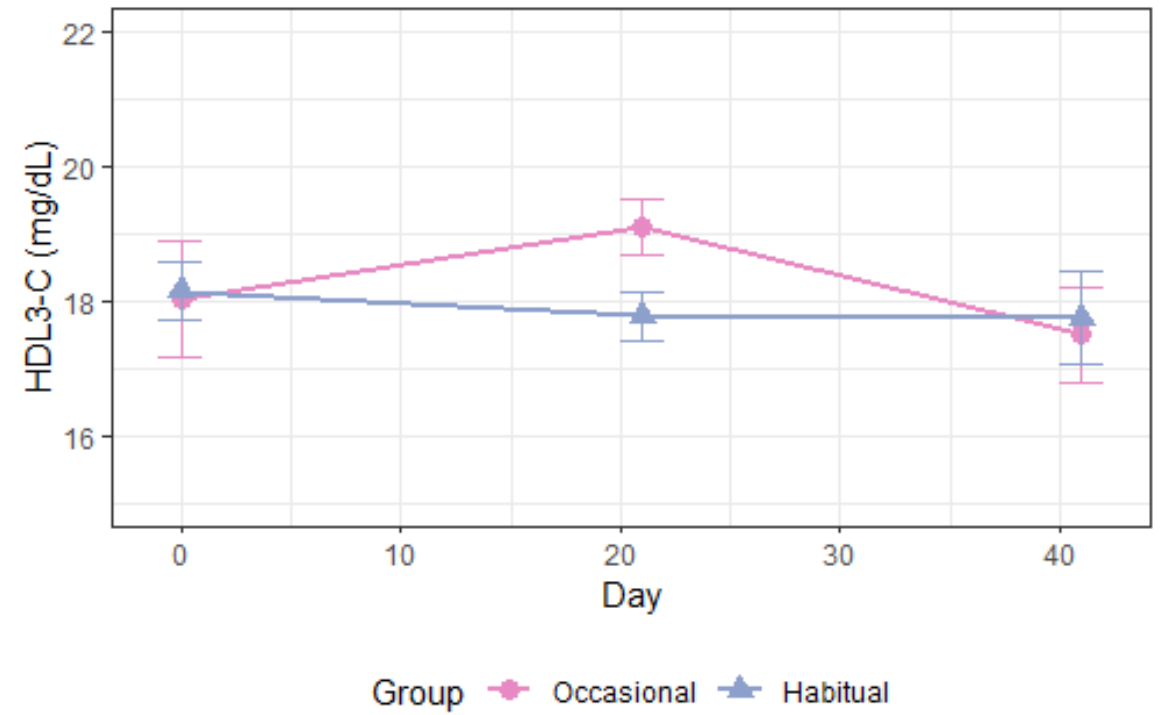
Figure 5. Circulating HDL 3 -C during 3 weeks in period 1 and 3 weeks in period 2. Occasional drinkers ( n = 10): habitual alcohol intake <2 drinks (~24 g) per week. Habitual drinkers ( n = 16): habitual alcohol intake ≥ 2 drinks (~24 g) per week, max 1 drink per day in women and 2 drinks per day in men. -C: cholesterol concentration, HDL: high-density lipoprotein.